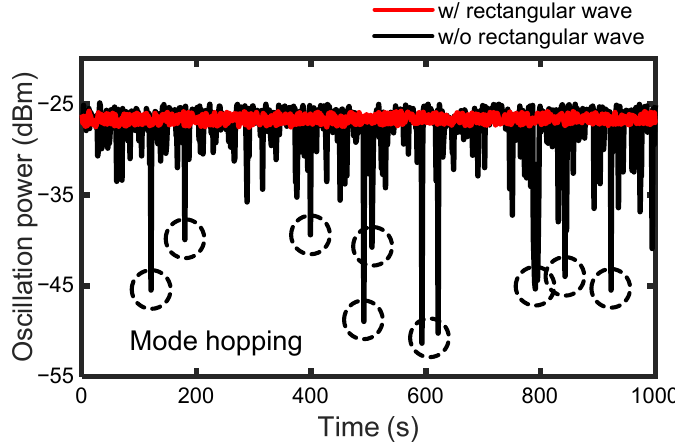
Figure 6. Time stability of OEO signal with and without a low-frequency rectangular wave modu- lation.